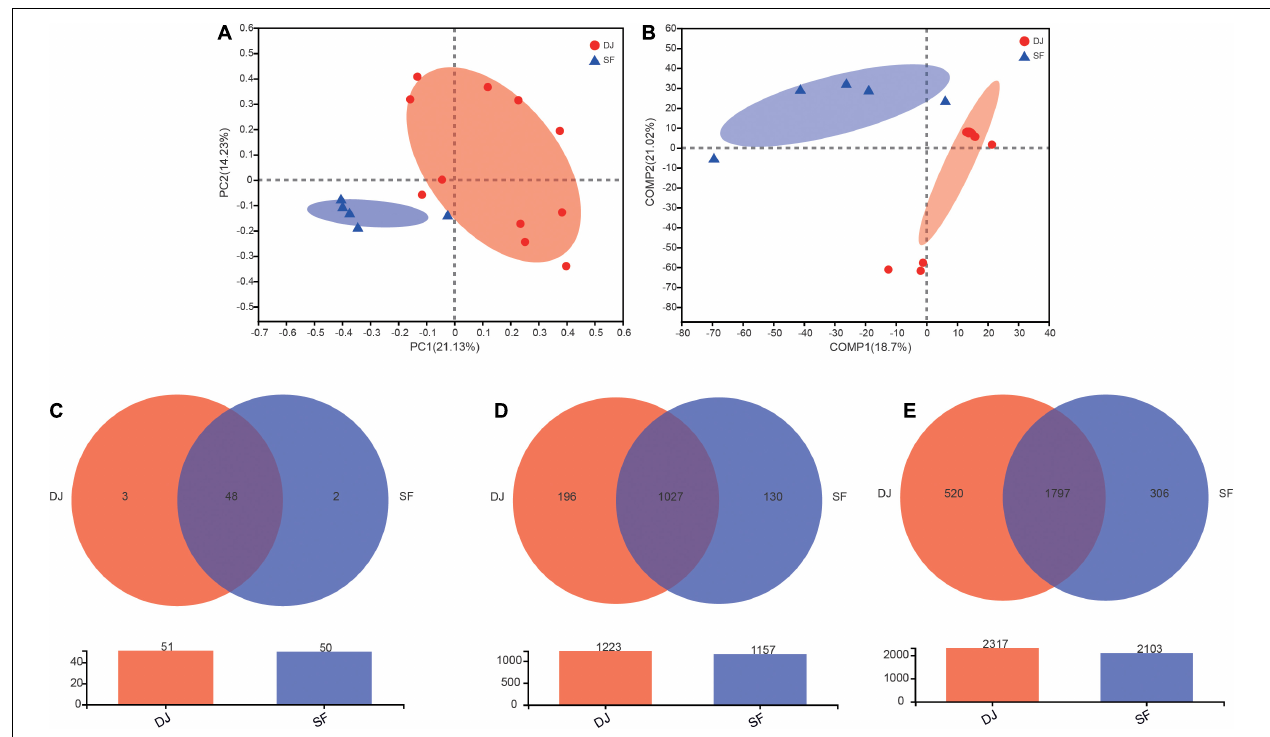
FIGURE 3 | Beta-diversity and Venn diagrams of bacterial communities in Dajiang and Sufu. (A) Principal component analysis (PCA); (B) Partial least squares discriminant analysis (PLS-DA); (C) Venn diagrams at the phylum level; (D) Venn diagrams at the genus level; (E) Venn diagrams at the species